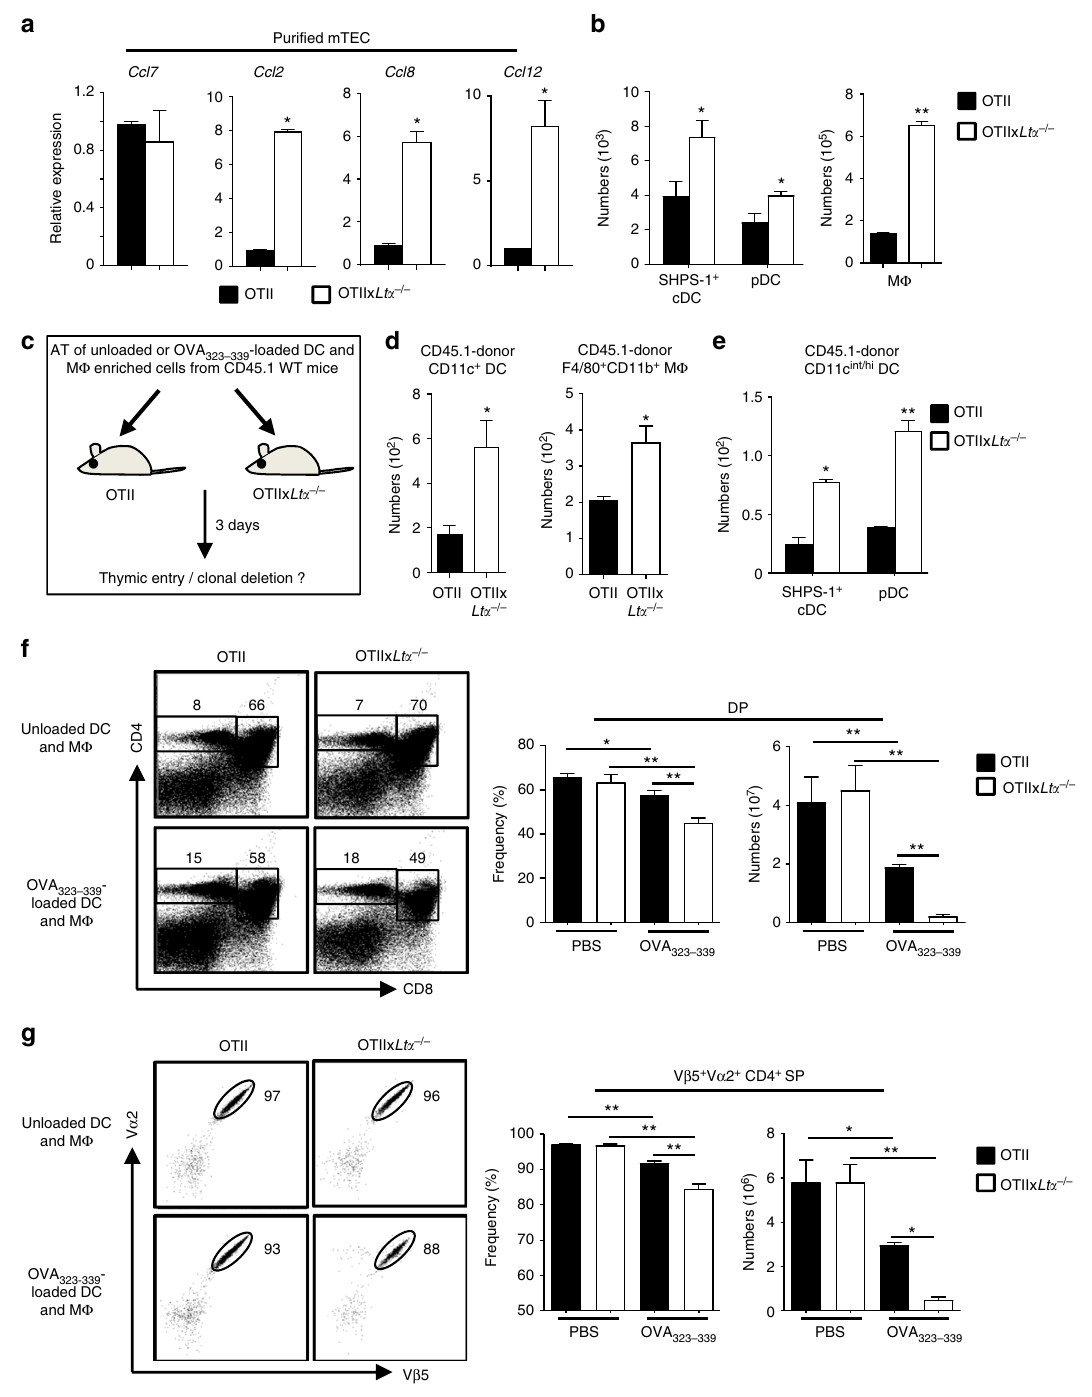
Fig. 7 LT α -regulated thymic entry of DCs and macrophages leads to an enhanced clonal deletion. a Ccl7 , Ccl2 , Ccl8 and Ccl12 mRNAs were measured by qPCR in puri fi ed mTECs (CD45 - Ep-CAM + BP-1 lo UEA-1 + ) from OTII- Rag2 − / − ( n = 3) and OTII- Rag2 − / − x Lt α − / − ( n = 3) mice. Data are representative from two independent experiment ( n = 1 – 2 mice per group). b Numbers of SHPS-1 + cDCs, pDCs and macrophages were analysed by fl ow cytometry in the thymus from OTII- Rag2 − / − and OTII- Rag2 − / − x Lt α − / − mice. c Experimental setup: AT of unloaded or OVA 323 – 339 -loaded DC and macrophage-enriched cells from CD45.1 congenic mice into OTII- Rag2 − / − or OTII- Rag2 − / − x Lt α − / − recipients. Thymic entry of DCs and macrophages of CD45.1 origin was analysed three days later. d , e Numbers of CD45.1 donor cDCs, macrophages ( d ), SHPS-1 + cDCs and pDCs ( e ) were analysed in the thymus by fl ow cytometry. f , g Flow cytometry pro fi les, frequencies and numbers of DP ( f ) and V β 5 + V α 2 + CD4 + SP ( g ) cells analysed three days after AT. b – g Data are representative from three to four independent experiments ( n = 3 – 4 mice per group and per experiment). ( b , c , d , f , g ) M Φ : macrophage. Error bars show mean ± SEM, * p < 0.05, ** p < 0.01, using one-tailed Mann – Whitney